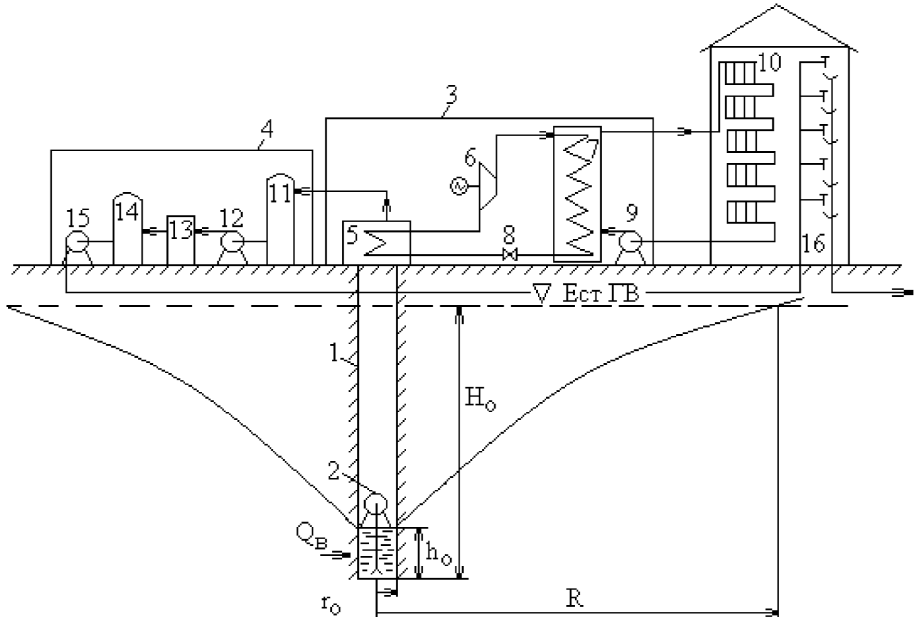
Fig. 1. Installation of potable water and heat supply at base of subsoil water. 1 – borehole; 2, 9, 12, 15 – pump; 3 – heat pump; 4 – module of water puri fi cation; 5 – evaporator; 6 – compressor; 7 – condenser; 8 – throttle gate; 10 – heat consumer; 11 – subsoil water tank;